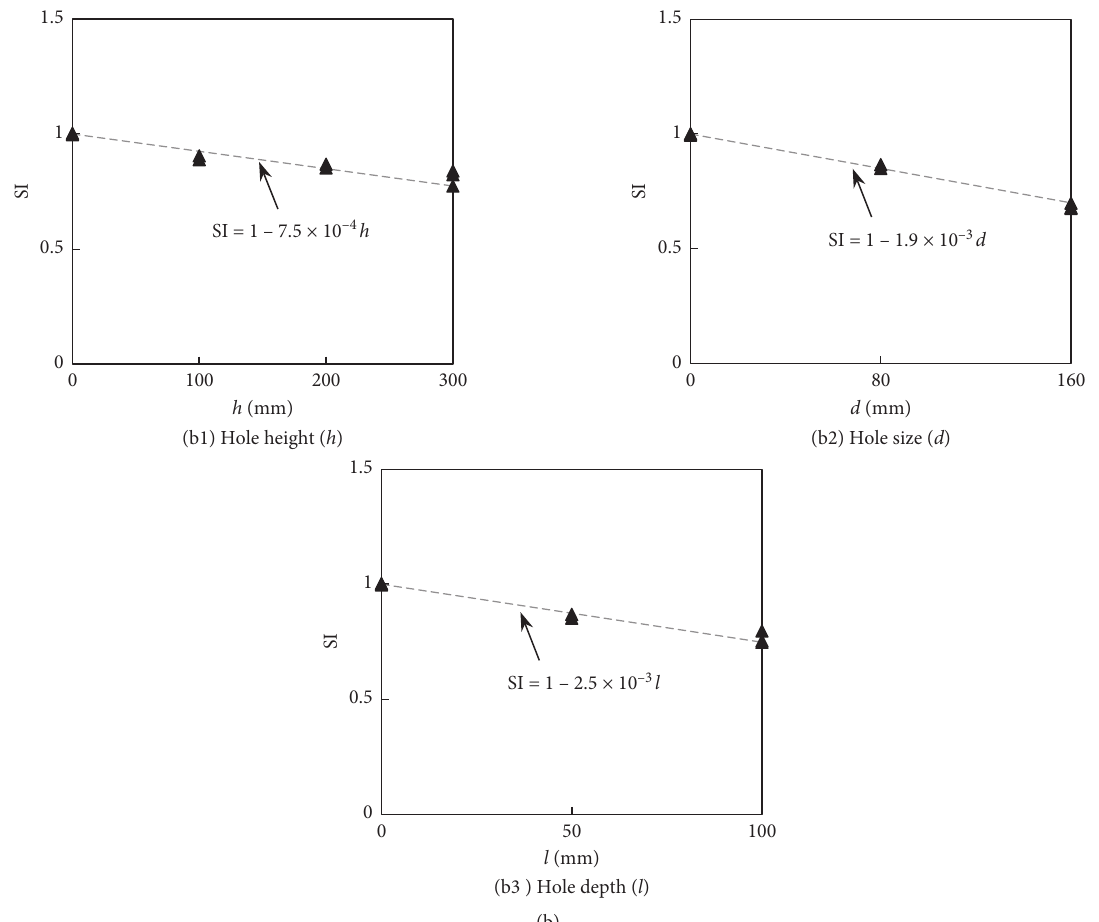
Figure 11: Strength index (SI) versus different parameters relation. (a) Square section. (b) Circular section.